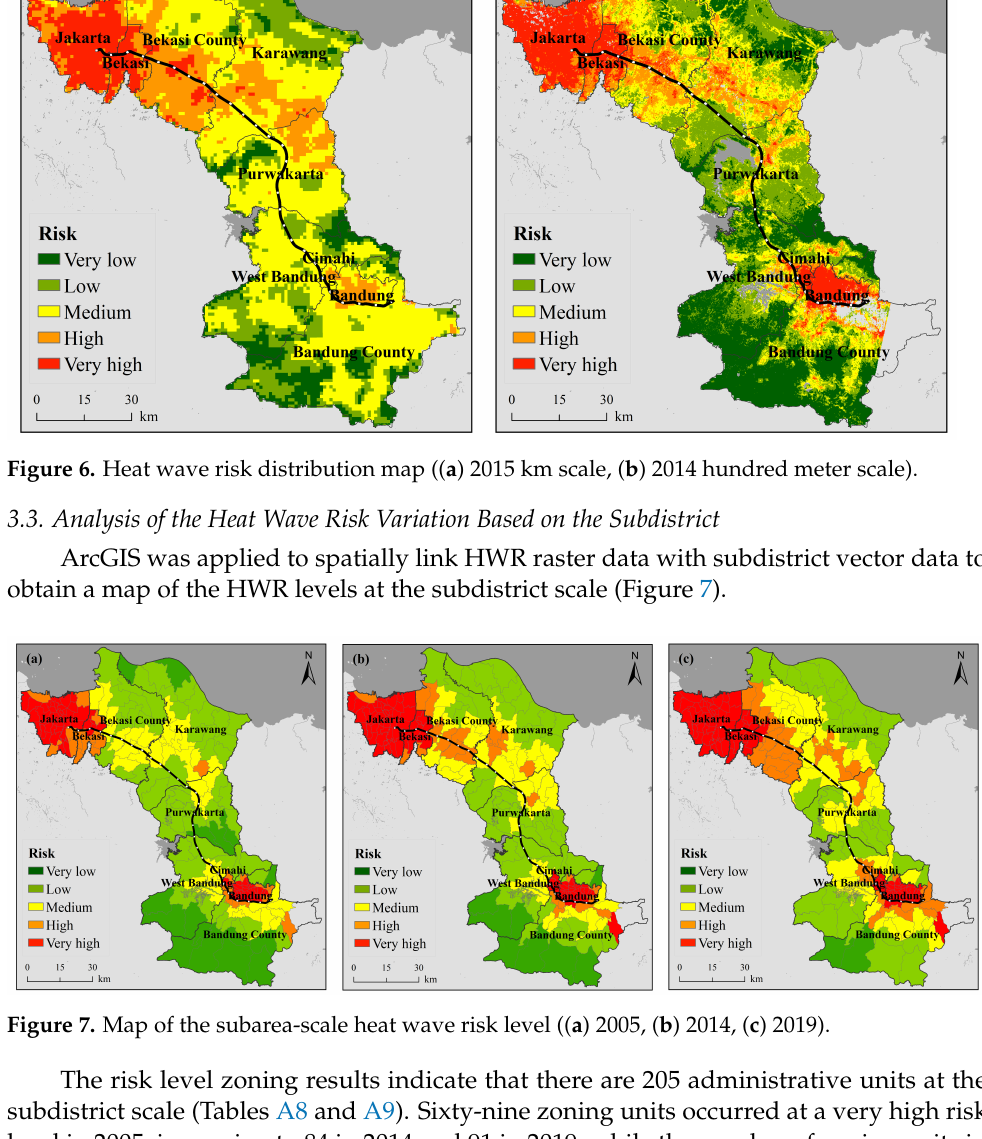
Figure 7. Map of the subarea-scale heat wave risk level (( a ) 2005, ( b ) 2014, ( c )